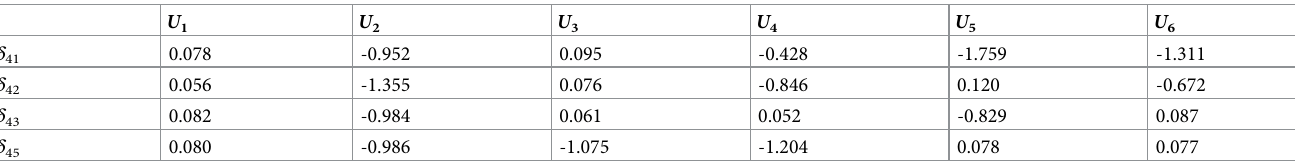
Table 27. The dominance of O 4 to